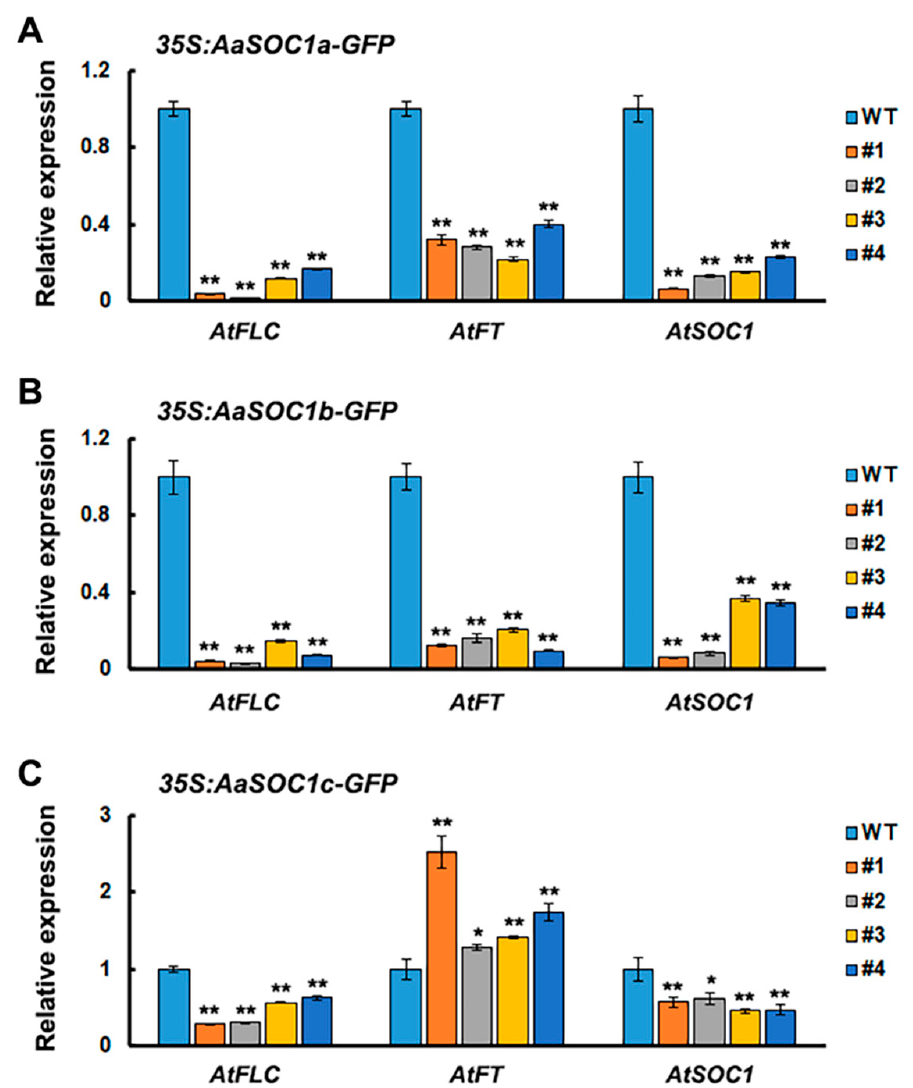
Figure 7. Relative expression level of endogenous flowering time genes in wild-type (WT) and transgenic Arabidopsis overexpressing AaSOC1a - ( A ), AaSOC1b - ( B ), and AaSOC1c-GFP ( C ) genes. The AtActin gene was used as an internal control, and the transcript level in WT was set as 1.0. Error bars represent the SE ( n = 3). Asterisks indicate significant differences between transgenic lines and WT plants (* p < 0.05; ** p < 0.01; Student’s t -test). FLC: Flowering locus C; FT: Flowering locus T. The number of the MADS-box genes identified in various plant species shows great difference. For example, in Arabidopsis and rice, 107 and 75 MADS-box genes were anno- tated, respectively, while 42 and 39 MADS-box genes were identified in Phyllostachys edulis and Dianthus caryophyllus , respectively, using a genome-wide search [5,10,14,19]. Using transcriptional sequencing, 58 MADS-box genes were identified in the flower buds of R. chinensis [17]. Similarly, in our study, 43 MADS-box genes were identified from the transcriptional data of A. amurensis flower organs using transcriptional sequencing. Both A. amurensis and Aquilegia coerulea belong to the family Ranunculaceae. In A. coerulea from Ranunculaceae, 47 MADS-box genes were annotated using a genome-wide search [20]. The MIKC-type members are the most common in the MADS-box gene family. Among the 107 MADS-box genes in Arabidopsis , 39 are MIKC-type [5], whereas among the 75 genes in rice, 38 are MIKC-type [10]. Meanwhile, the identified 43 AaMADS genes in A. amurensis contain 38 MIKC c -type and 3 MIKC*-type (Figure 1). The vast majority of the